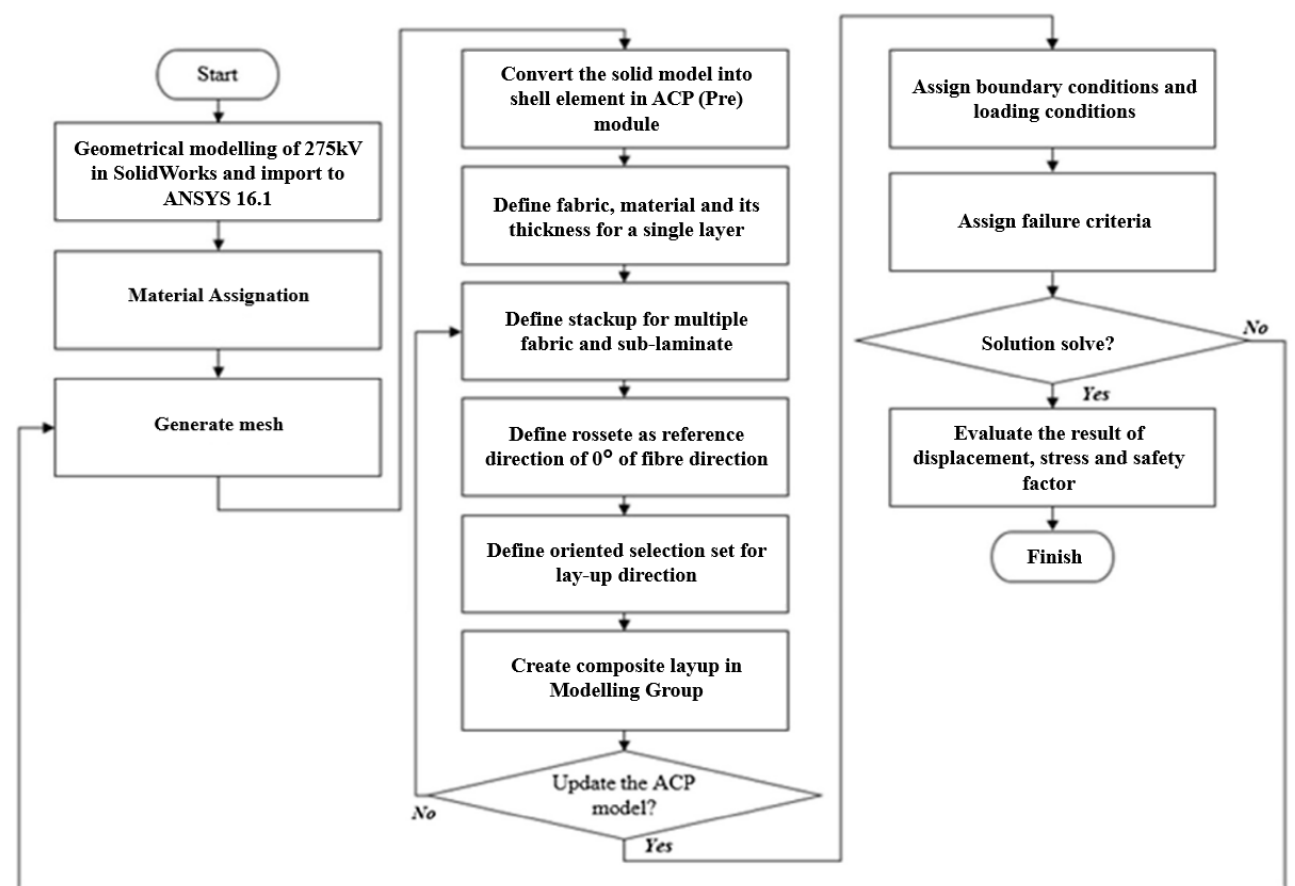
Figure 1. Workflow of computational simulation analysis of cross ‐ arm assembly.